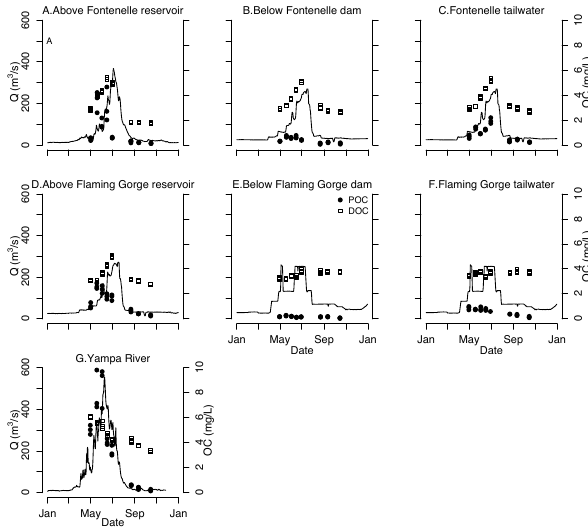
Figure 2. Discharge (line, Qm 3 s − 1 ) plotted for 2011 along with particulate organic carbon (POC; replicate samples plotted) and dis- solved organic carbon (DOC; replicate samples plotted) concentra- tions from sampling sites located on the Green and Yampa rivers. Letters A–G preceding the site names correspond to sites A–G